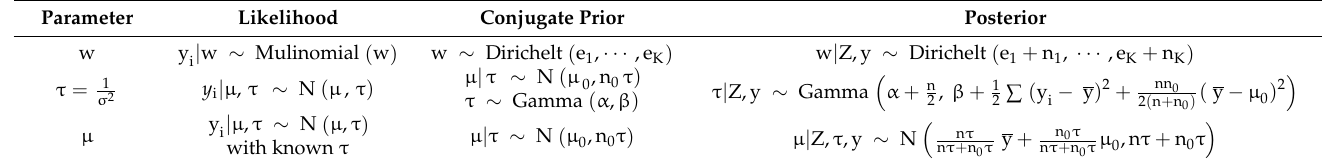
Table 1. Posterior distribution of the proposed Bayesian mixture